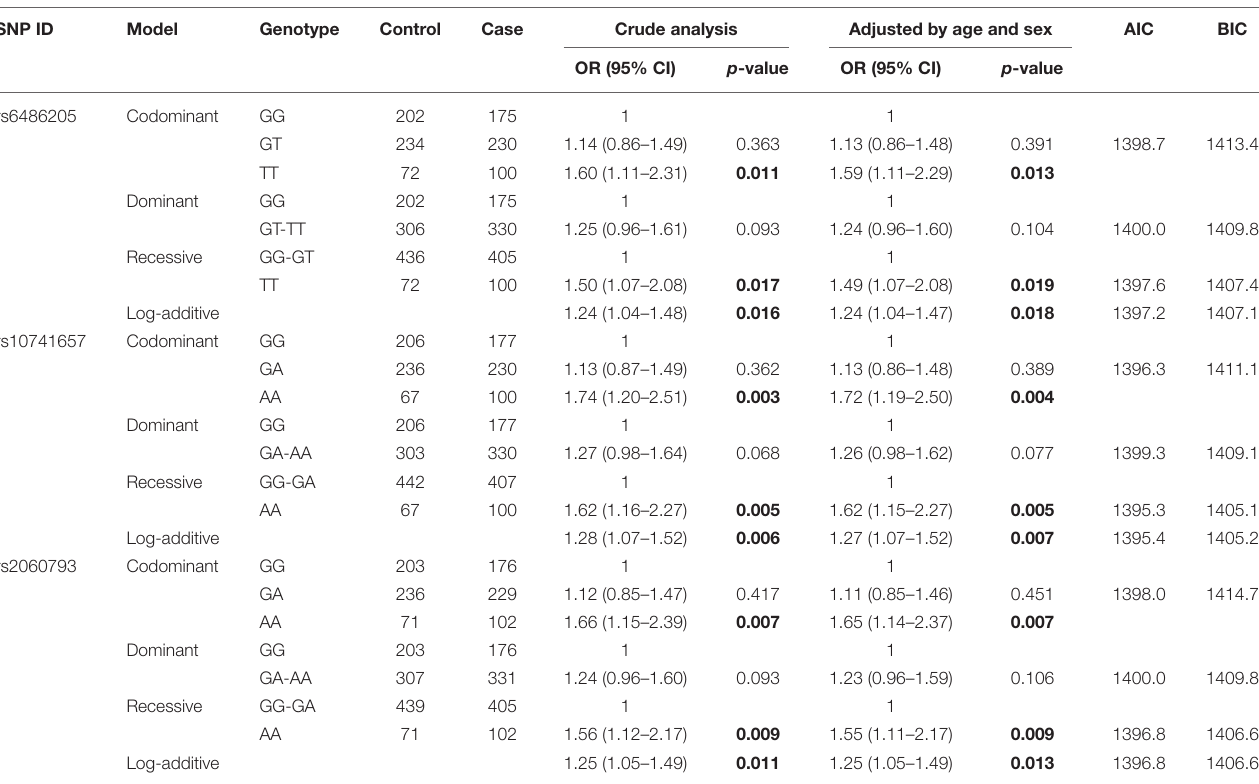
TABLE 3 | Association between CYP2R1 polymorphisms and CHD